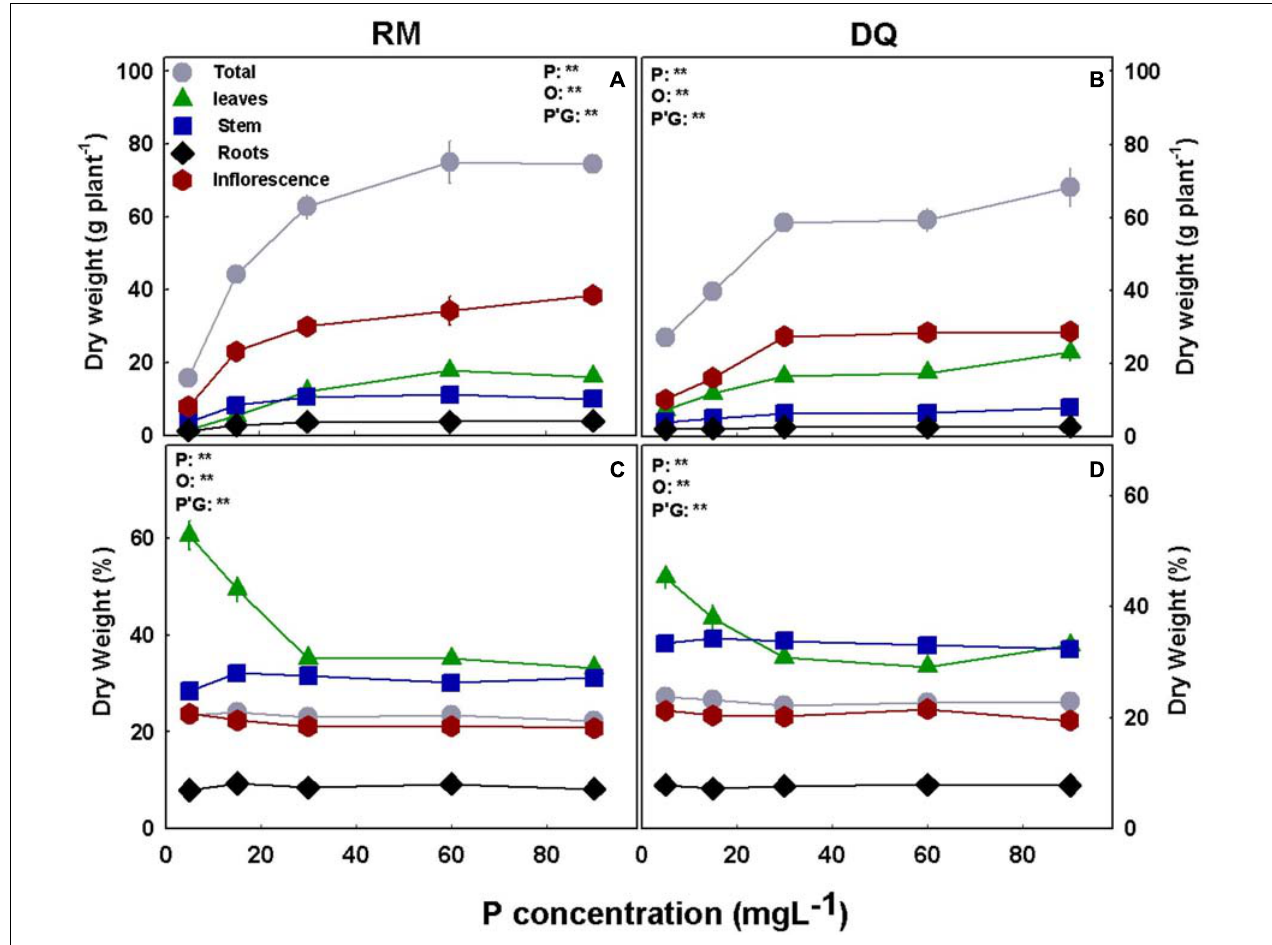
FIGURE 2 | Effect of P nutrition on biomass of the root and shoot organs in mature medical cannabis plants. Dry weight (A,B) and percentage of dry weight (C,D) of leaves, stems, roots, inflorescences, and total plant of two medical cannabis cultivars, RM (A,C) and DQ (B,D) . Presented data are averages ± SD ( n = 6). Results of two-way ANOVA indicated as ** P < 0.05, F -test; NS, not significant P > 0.05, F -test. In the ANOVA results, P, phosphorus; G, genotype; and P*G, the interaction between P and